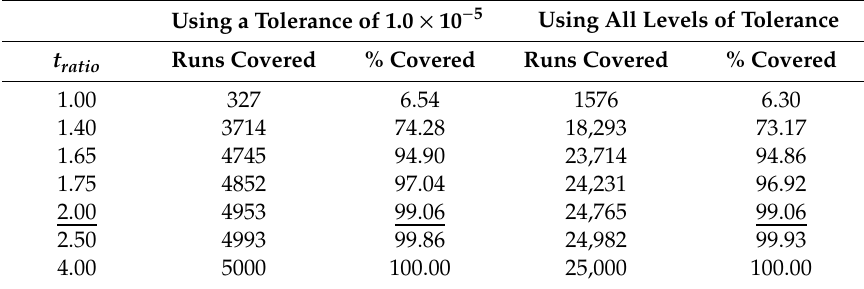
Table 9. Number and percentage of runs covered by possible ratios of time, considering 5000 and 25,000 runs: 50 per each of 20 functions with populations of 5 sizes, at 5 levels of tolerance. Using a Tolerance of 1.0 × 10 − 5 Using All Levels of Tolerance t ratio Runs Covered % Covered Runs Covered %